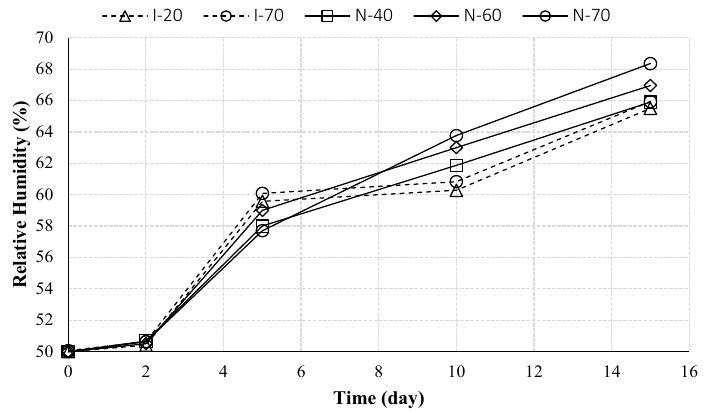
Figure 5. Relative humidity profiles for all samples varies with time increasing at same depth ( x = 5.5 inch).